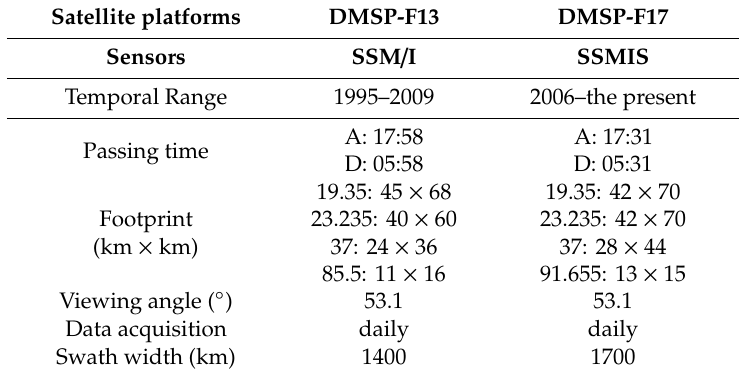
Table 1. Parameters of SSM / I and SSMIS sensors on various satellite platforms.